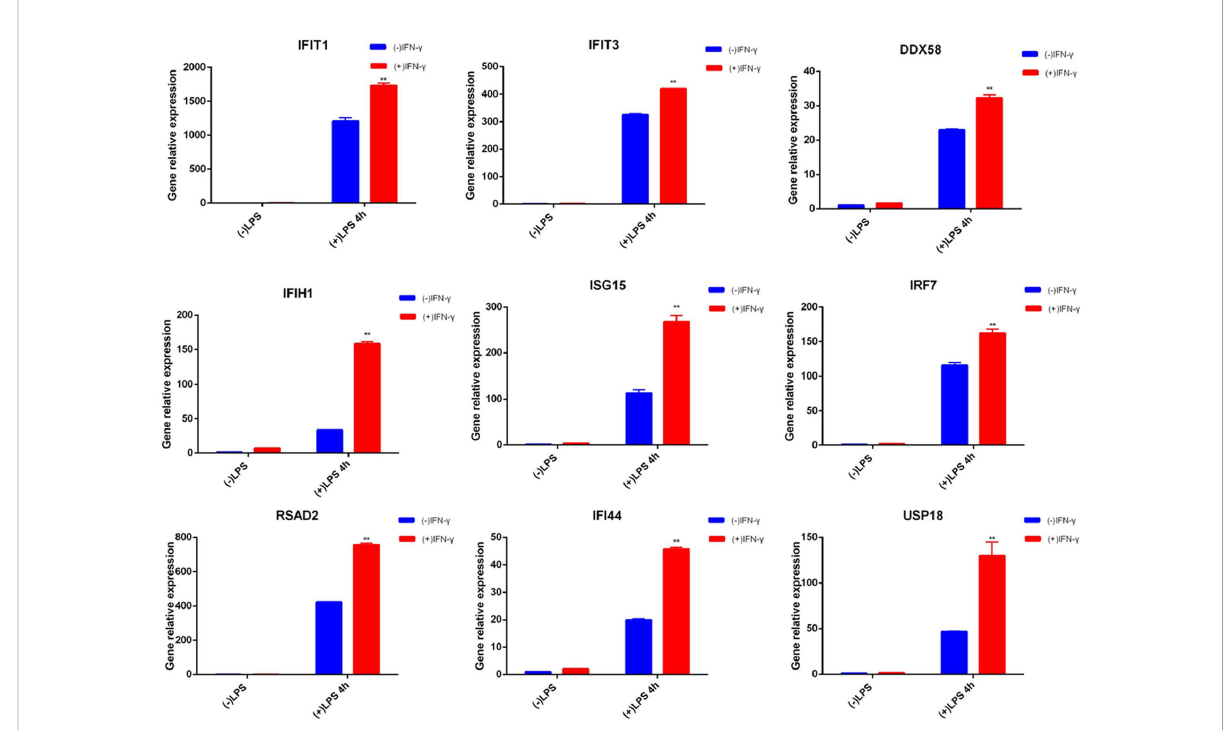
FIGURE 4 qRT-PCR of related genes. Blue represents cells not pretreated with IFN- g , and red represents cells treated with IFN- g for 6 hours. The two groups of cells were treated with LPS for 4 hours after cultured in normal medium for 24 hours. ISG mRNA was measured by qRT-PCR, normalized by Gapdh, and expressed as fold induction. Nine genes are examples of memory ISGs in the transcriptome, respectively. Data represent the mean ± SD of three independent experiments. Statistically signi fi cant differences are indicated (Student ’ s t test, **P <